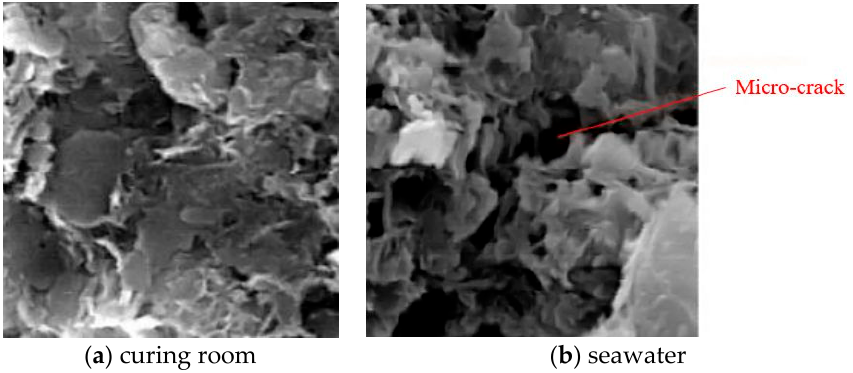
Figure 11. SEM pictures of soil-cement. ( a ) Curing room and ( b ) seawater.